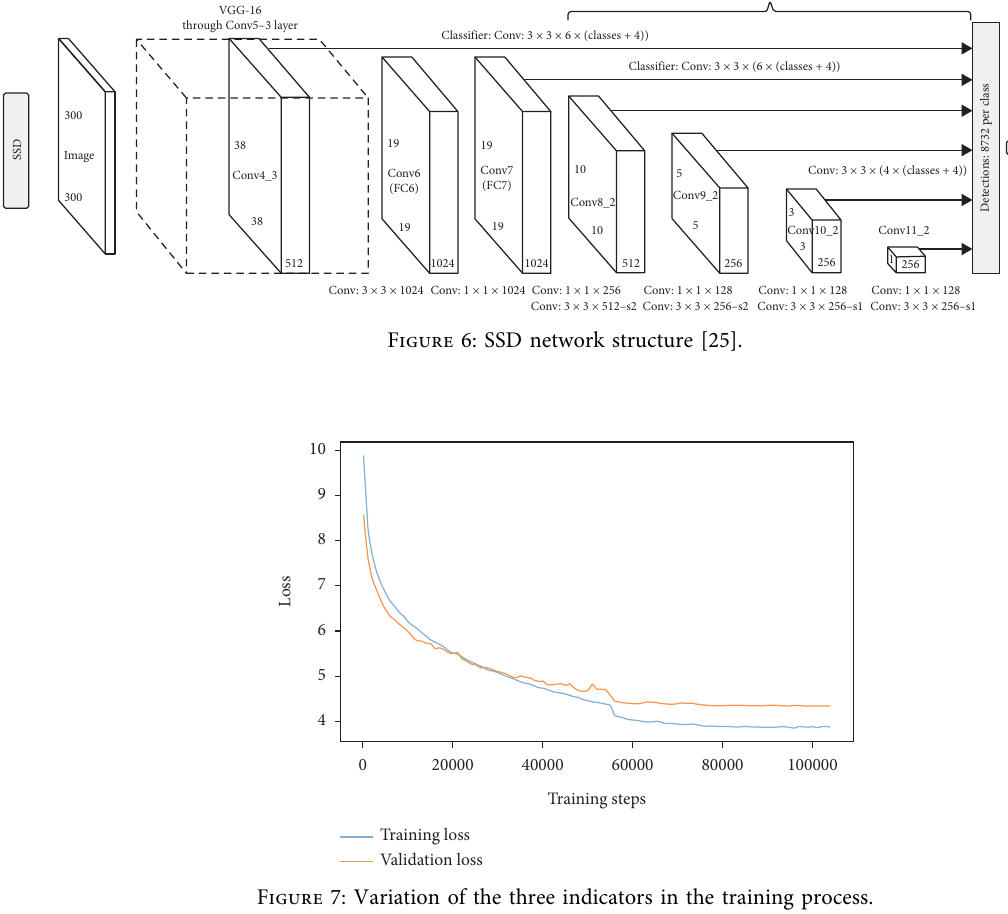
Extra feature layers